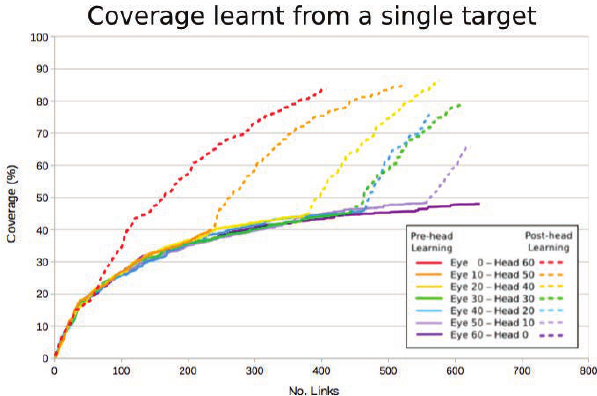
Figure 9. Graph showing the percentage of map covered as more links are learnt, based on learning with a single target for 60 minutes with the head constraint being released after 10 minute intervals across di(cid:636)er- ent trials (solid lines represent eye-only phase). Best viewed in